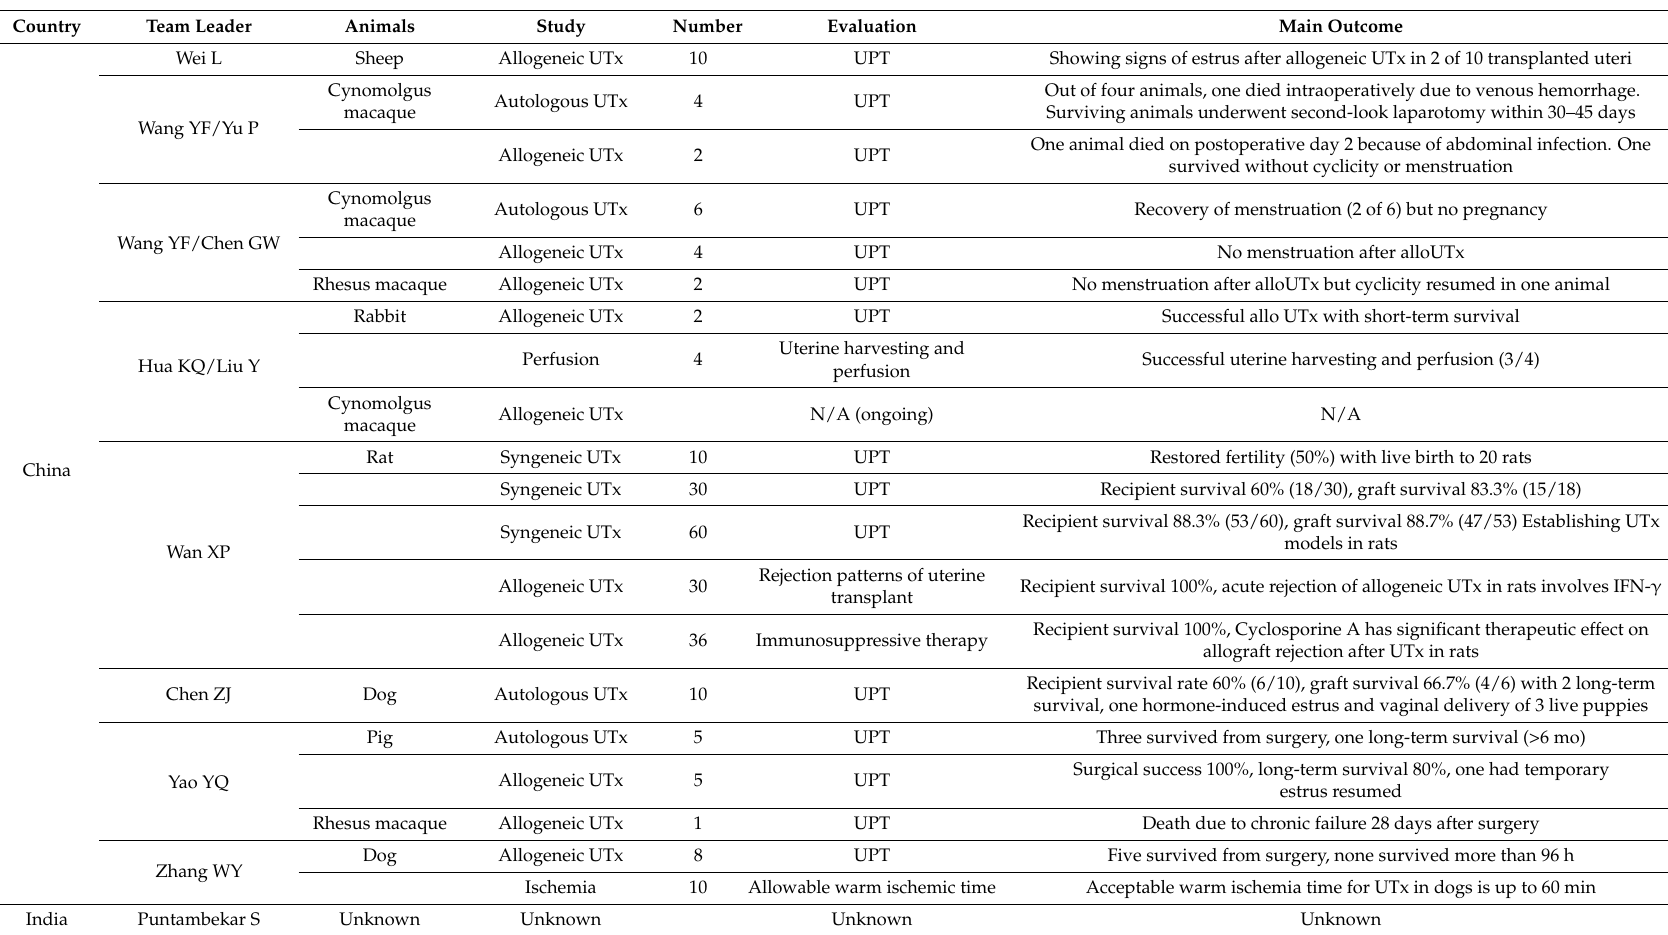
Table 2. Basic UTx research in